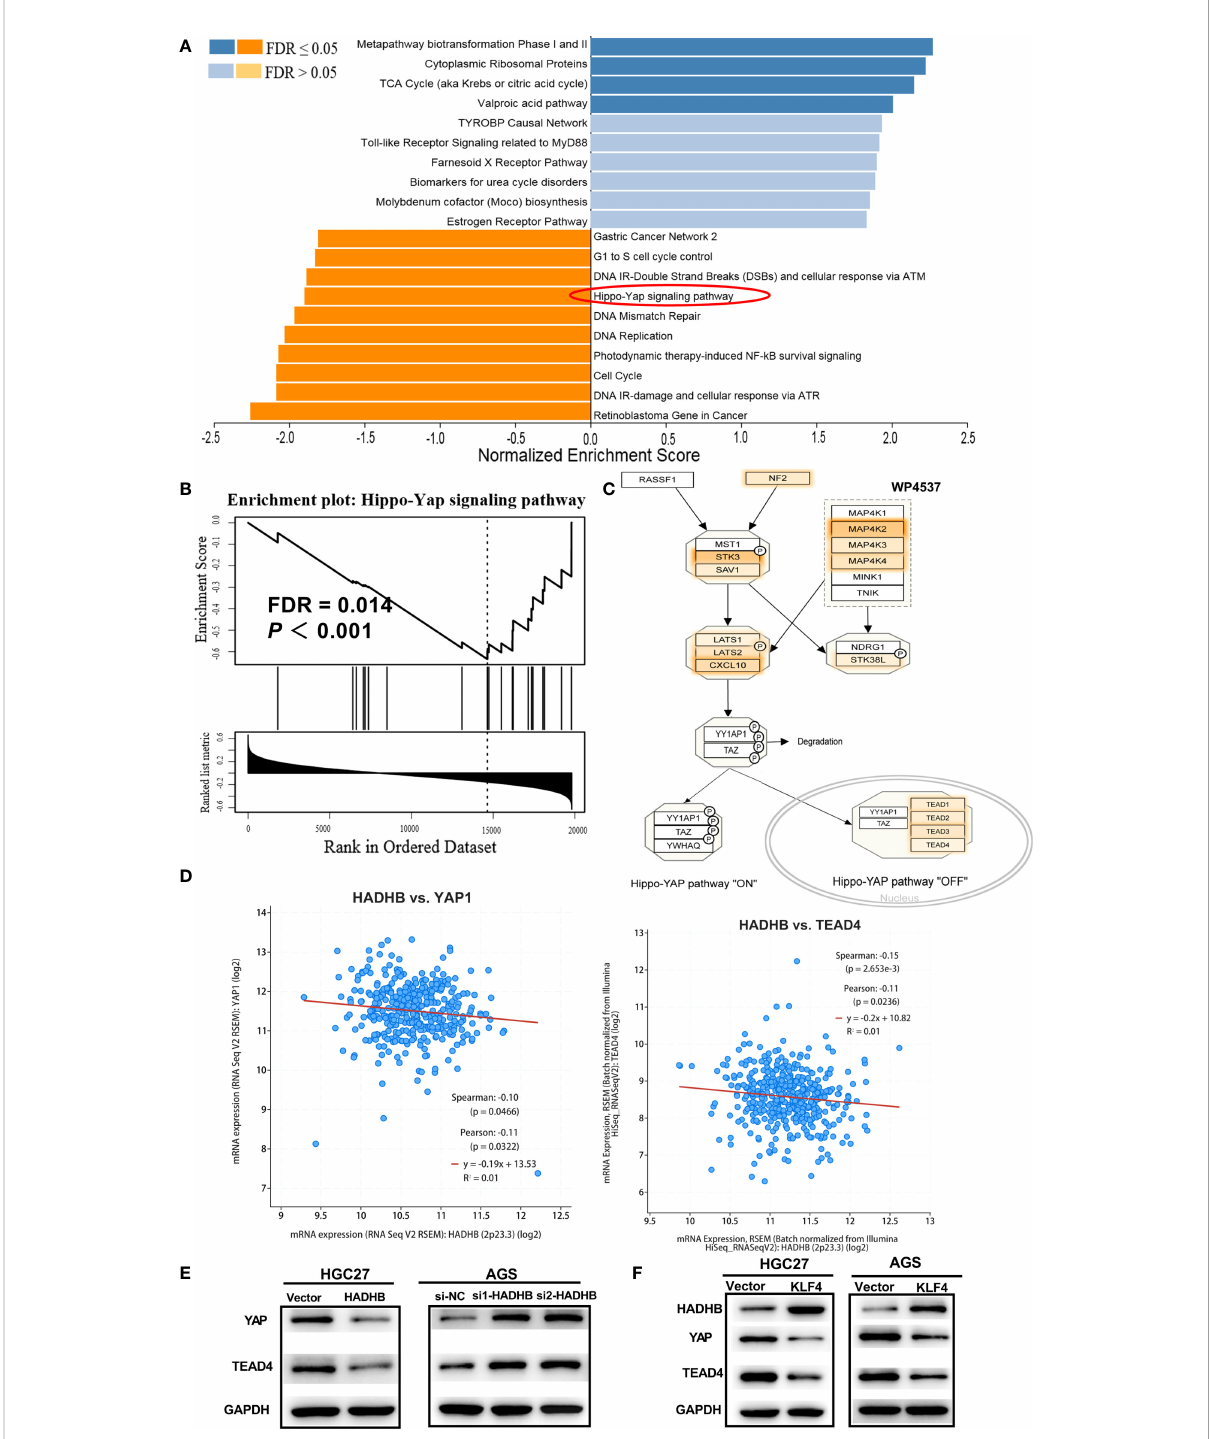
FIGURE 6 HADHB upregulation restrained the regulation of the Hippo-YAP signalling pathway (A) . Pathway enrichment analysis was carried out using GSEA and WebGestalt based on TCGA-STAD database. (B) . Enrichment plot of the Hippo-Yap signalling pathway. (C) . Pathway view of the Hippo-YAP signalling pathway, with the leading-edge protein highlighted. (D) . Analysis of the correlation between HADHB and YAP, as well as HADHB and TEAD4 was performed using the cBioPortal platform. ((E – F)) . The expression of HADHB and the Hippo-YAP signalling pathway- related factors (YAP and TEAD4) in the transfected AGS and HGC27 cells was evaluated via western